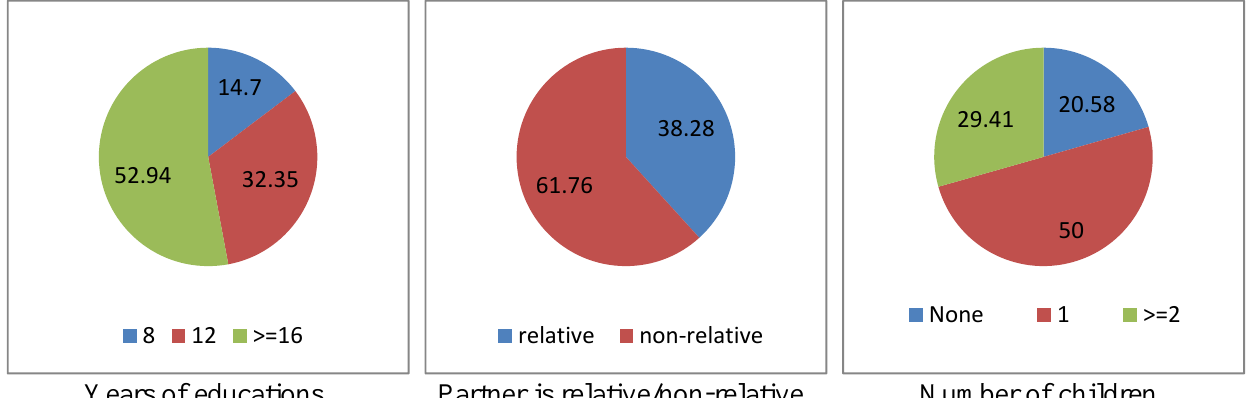
Fig. 1. Personal characteristics of the participants